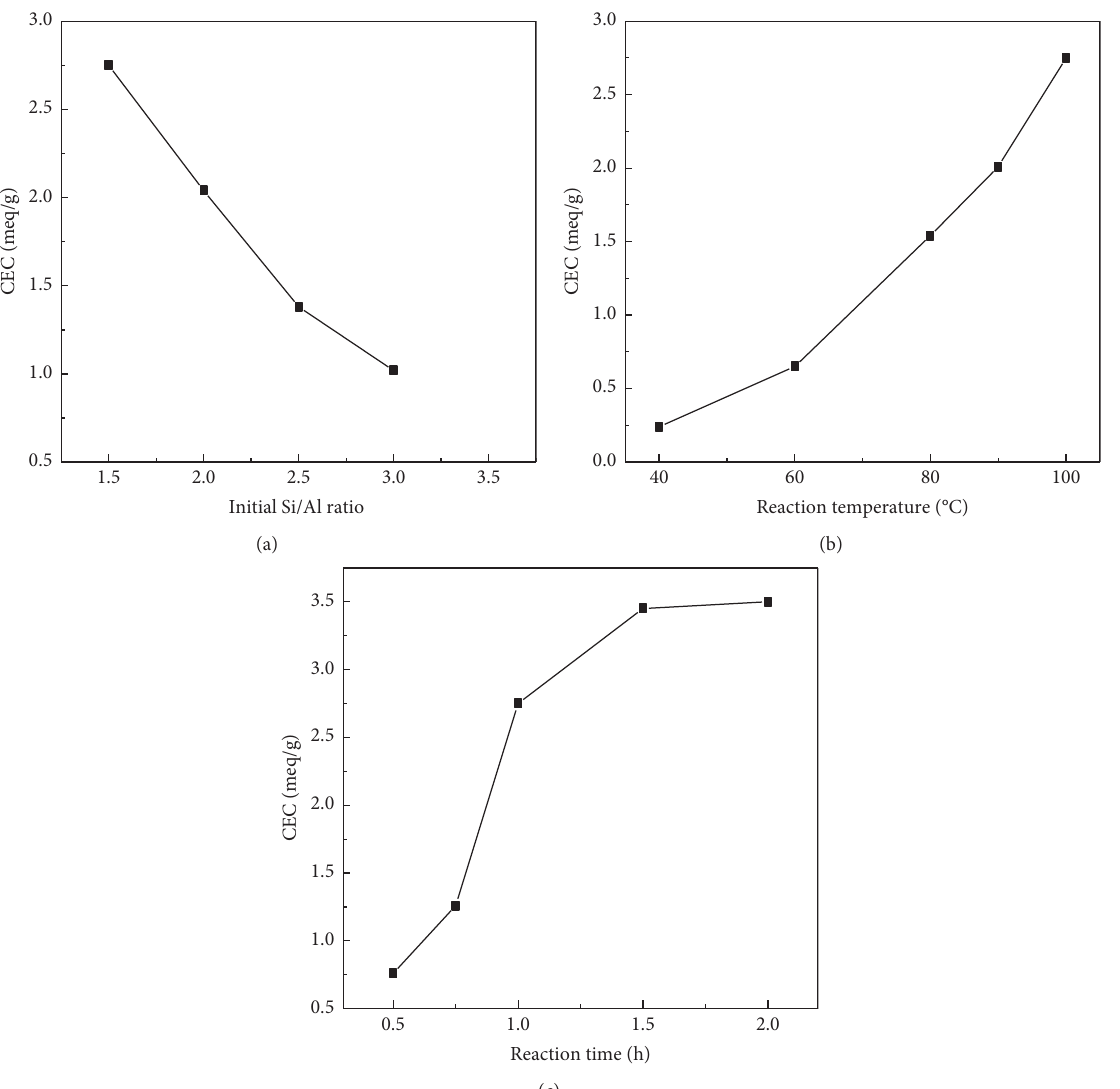
Figure 4: Effects of initial Si/Al ratio on the CEC of the synthesized EMRZ (synthesis conditions: (a) reaction temperature, 100 ° C; reaction time, 1h; (b) initial Si/Al ratio, 1.5; reaction time, 1 h; (c) initial Si/Al ratio, 1.5; reaction temperature, 100 ° C).